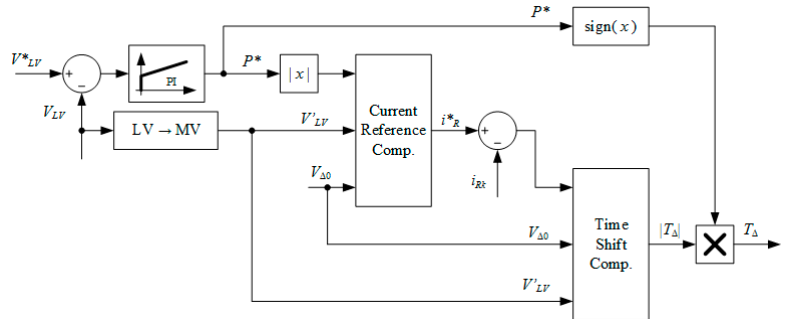
Figure 5. Low voltage (LV)-side converter control scheme.